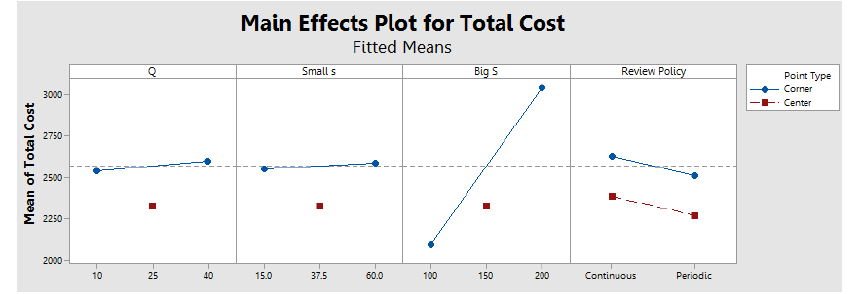
Figure 11. Main effect plot of full factorial design.